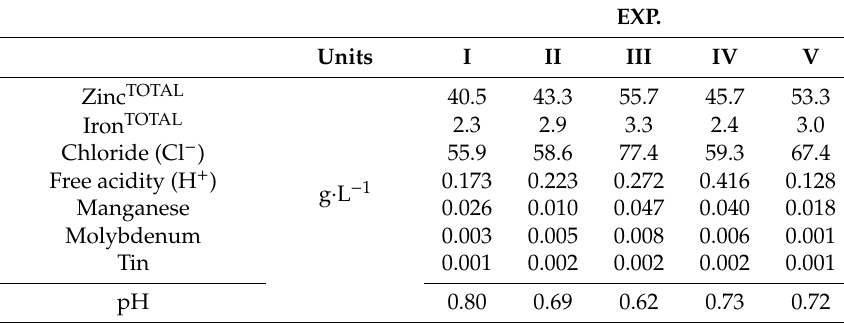
Table 6. Chemical characterization of the final stripping phase in EXP